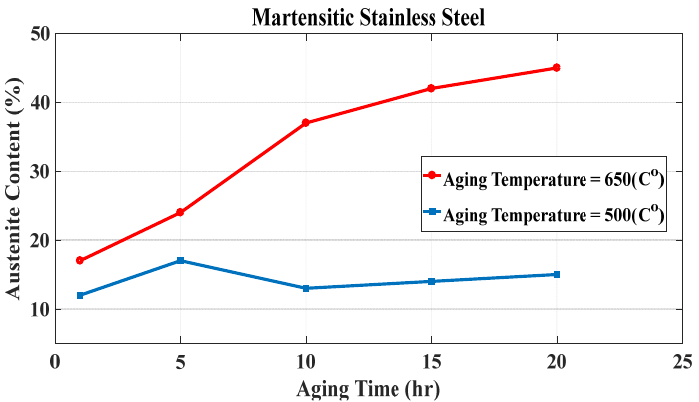
Fig. 4. Effect of aging time on the austenite volumetric percentage at two aging temperatures.